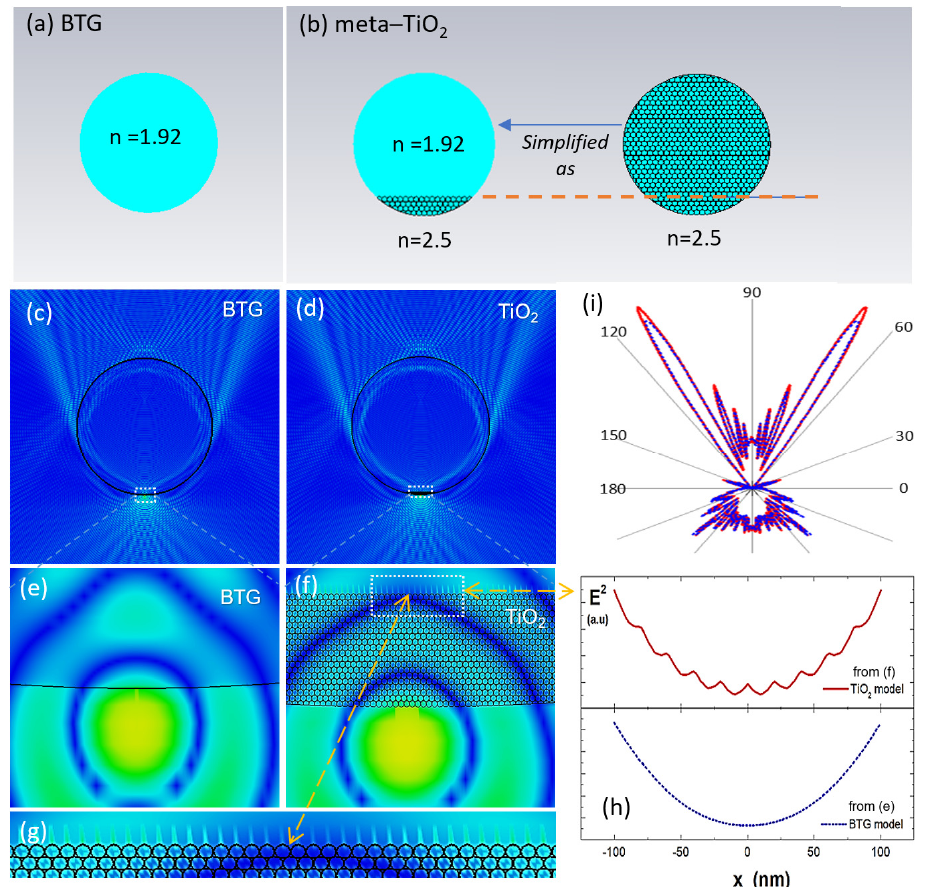
Figure 6. Modeling and comparison of electric field distribution of 20- µ m-diameter ( a ) BTG and ( b ) meta-TiO 2 micro lenses under electric dipole source excitation. Field distribution for dipole source scattered by ( c ) BTG particle, and ( d ) TiO 2 particle. ( e ) Magnified view of near-field distribution in ( c ) marked zone. ( f ) Magnified view of near field around dipole source in ( d ) marked area. Noting the formation of tiny photonic jet array in ( f ), and ( g ) corresponding magnified view. ( h ) 1D plots of near-field intensity along indicated location in (f), and the same location in ( e ) (not shown). ( i ) Far-field scattering diagram for BTG (blue dash) and TiO 2 (red solid), showing the same radiation pattern for both lenses but with large intensity at the main lobe for TiO 2 .